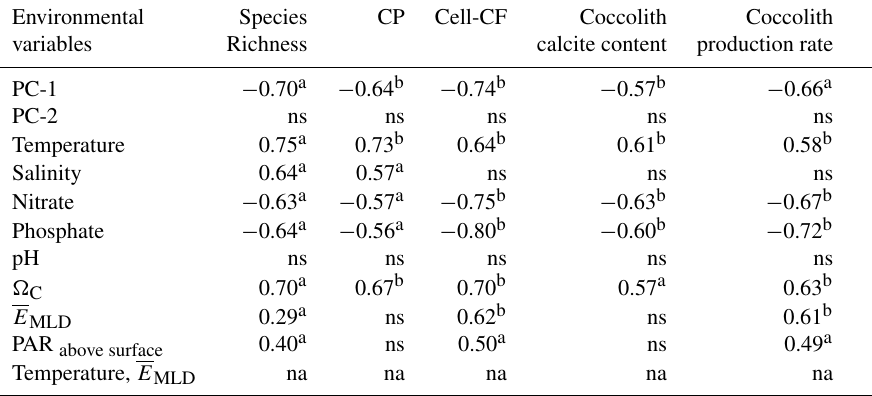
Table 2. Spearman’s rank correlations of species richness, calcification parameters and environmental variables. PC-1 is a combination